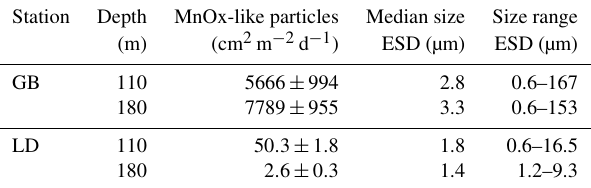
Table 4. MnOx-like particle fluxes and size as equivalent spherical diameter (ESD) determined by image analysis in GB and LD.